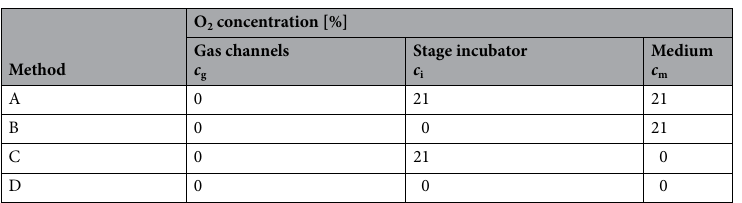
Table 3. Computational settings in consideration to generate the hypoxic condition H0 flow : oxygen concentrations c g and c i in the supplied gas mixtures to the gas channels and the stage incubator, respectively, and oxygen concentration c m in the cell culture